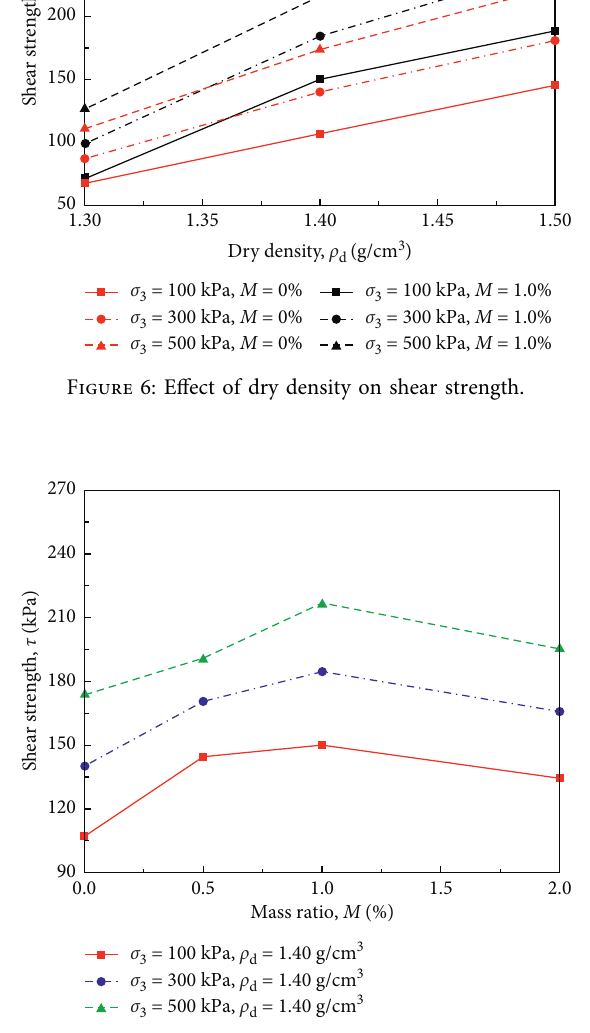
Figure 7: Effect of mass ratio on shear